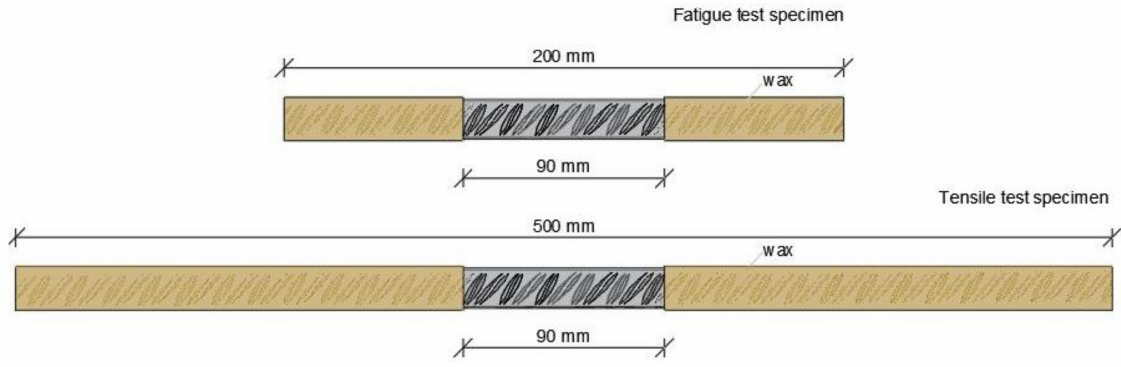
Figure 5. Schematic representations of the exposed-to-corrosion lengths of the specimens.